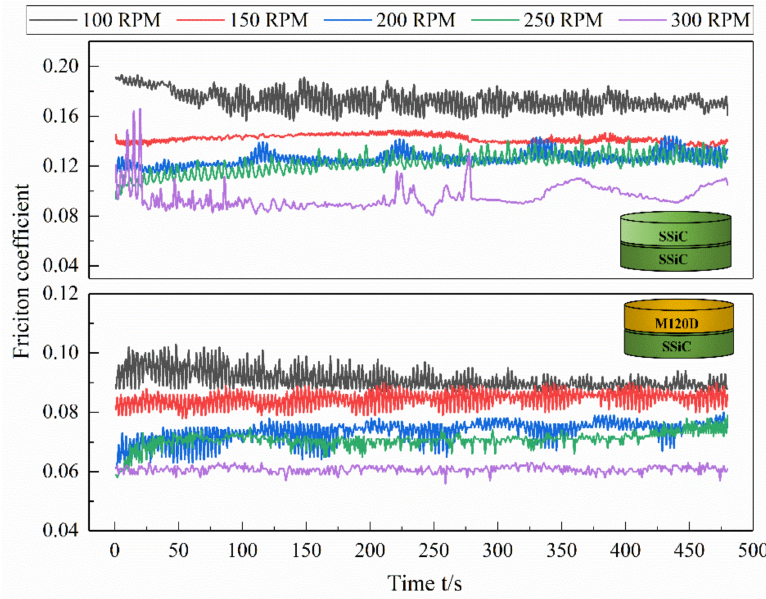
Figure 4. Real-time friction coefficient of friction pairs with different materials under 100–300 rpm. Table 5. Data of friction coefficient and surface temperature of friction pairs for 1-A1 and 1-A2 groups.